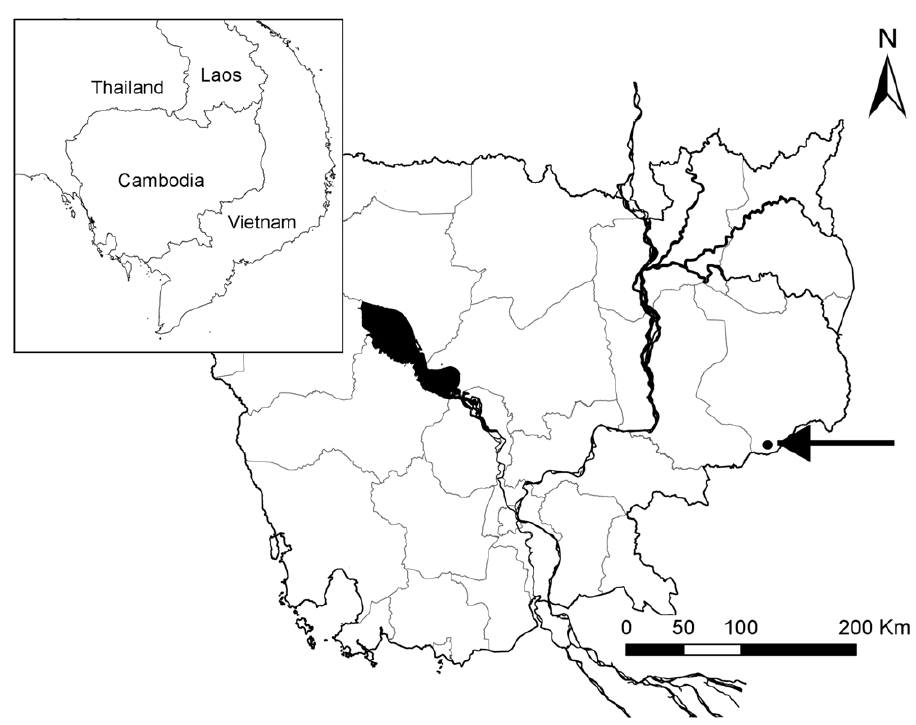
Figure 4. Location of Seima Protection Forest, Cambodia. The study site is indicated on the map.